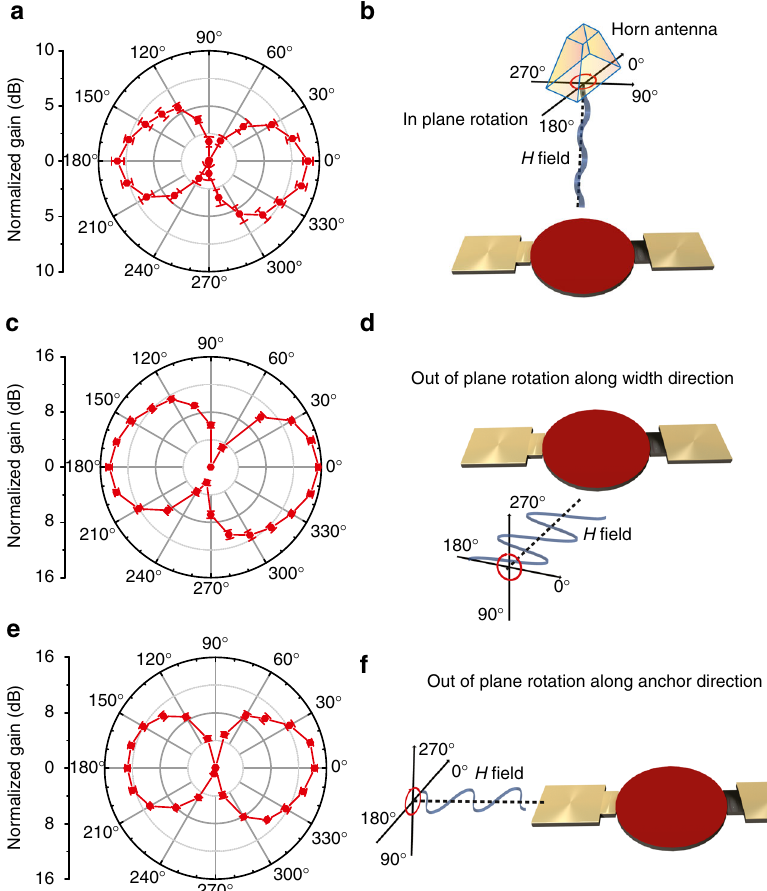
Fig. 4 ME FBAR antenna measurements under a rotating linearly polarized standard antenna along three major rotational axes. a , c , e Antenna polar gain charts for the in-plane rotation along the width direction, out-of-plane rotation along the width direction c , and out-of-plane rotation along the anchor direction e . b , d , f . Schematic representations of the experimental setups for a , c and e respectively. The sinusoidal wave along 0° or 180° direction denotes the propagating H - fi eld component of the incoming electromagnetic